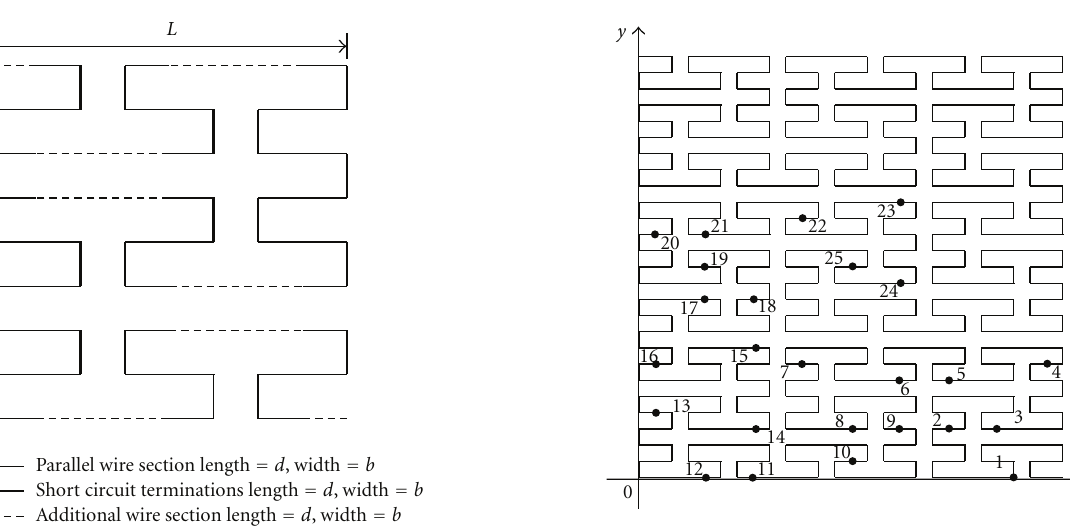
Figure 3: Feed points selected of Peano fractal antenna for simulation.